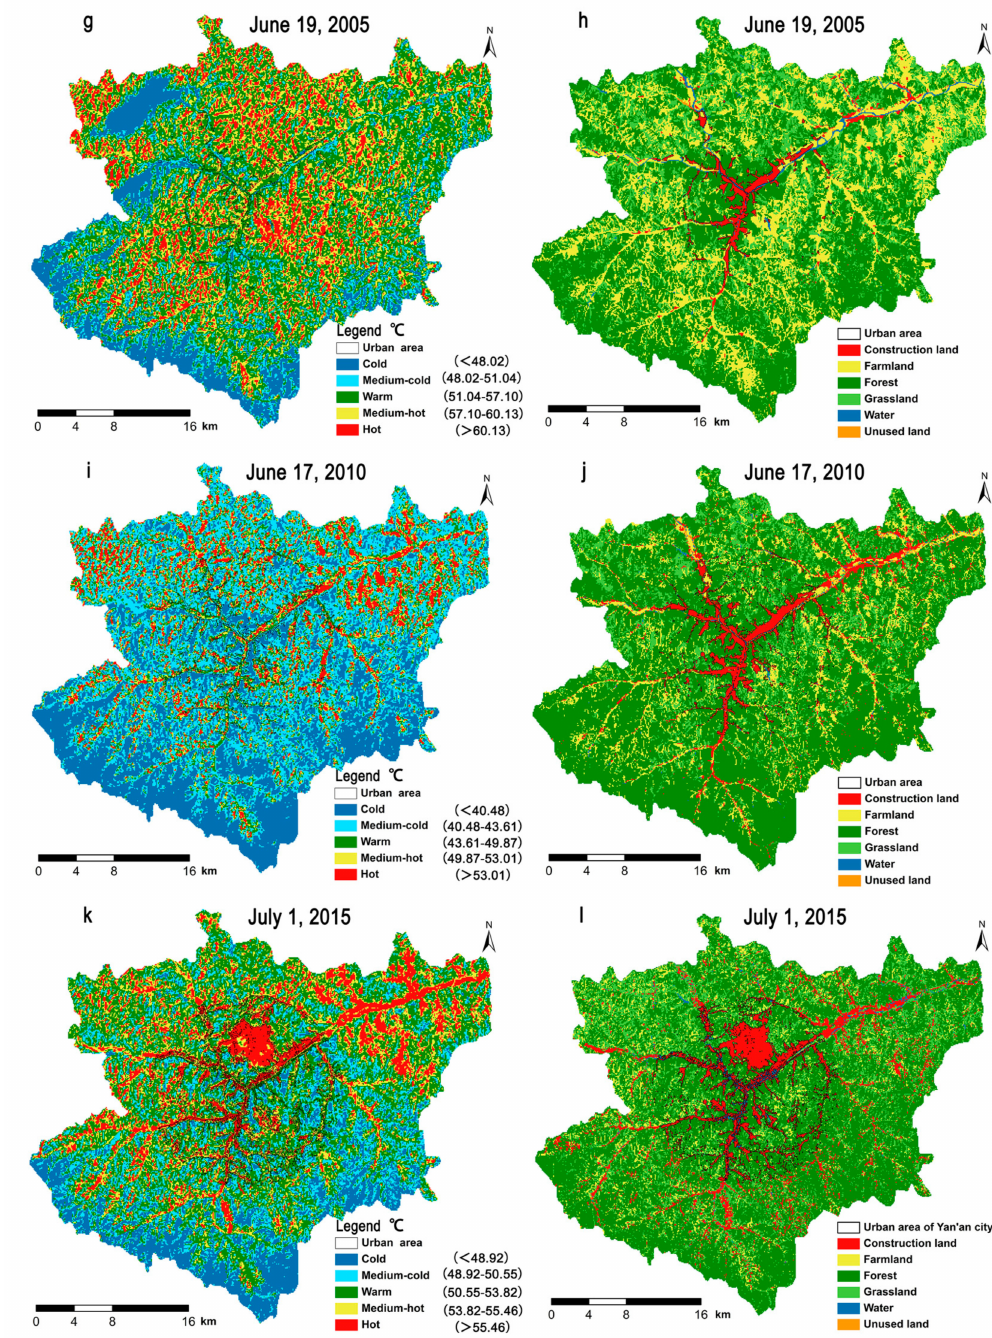
Figure 5. ( a – f ) Maps comparing the spatial distribution of the land surface temperature and land use/cover during the three periods from 1990 to 2000; ( g – l ) Maps comparing the spatial distribution of the land surface temperature and land use/cover during the three periods from 2005 to